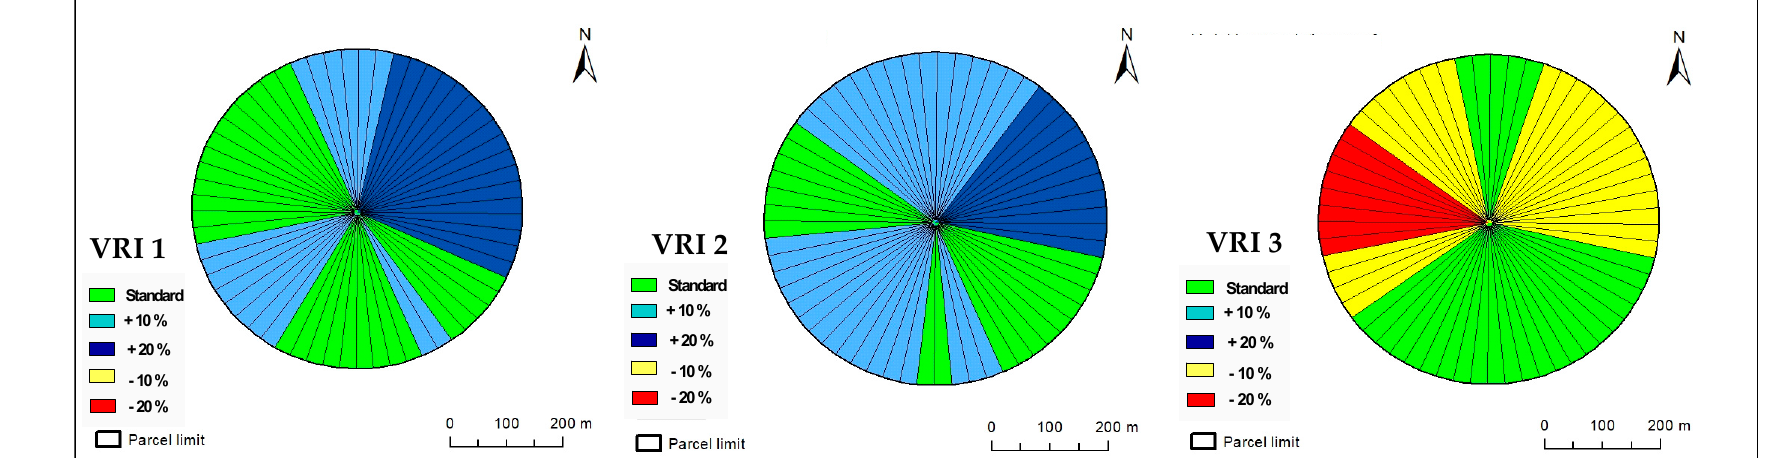
Figure 10. Variable rate irrigation (VRI) maps 1, 2, and 3 implemented in the “Eucalyptus” field between 14 June and 13 September 2017.